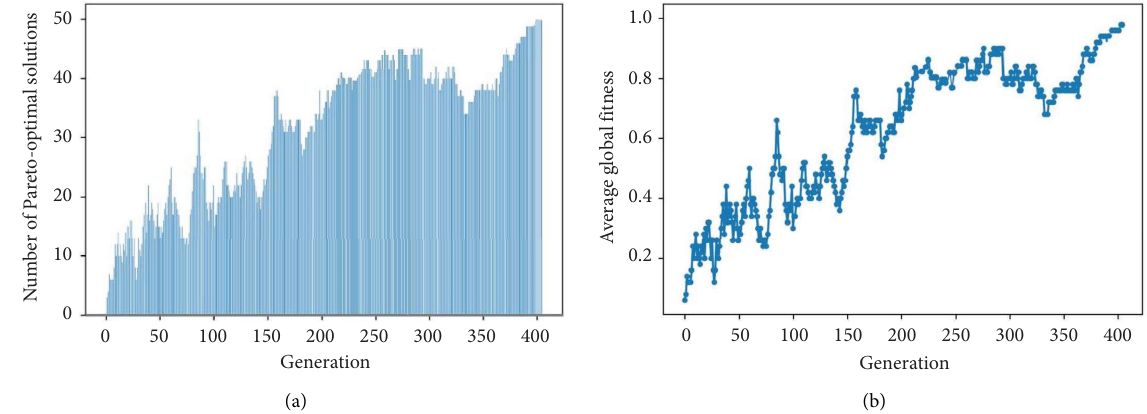
Figure 5: Changes in: (a) number of Pareto-optimal solutions; (b) Average global ftness as the number of generations increases.